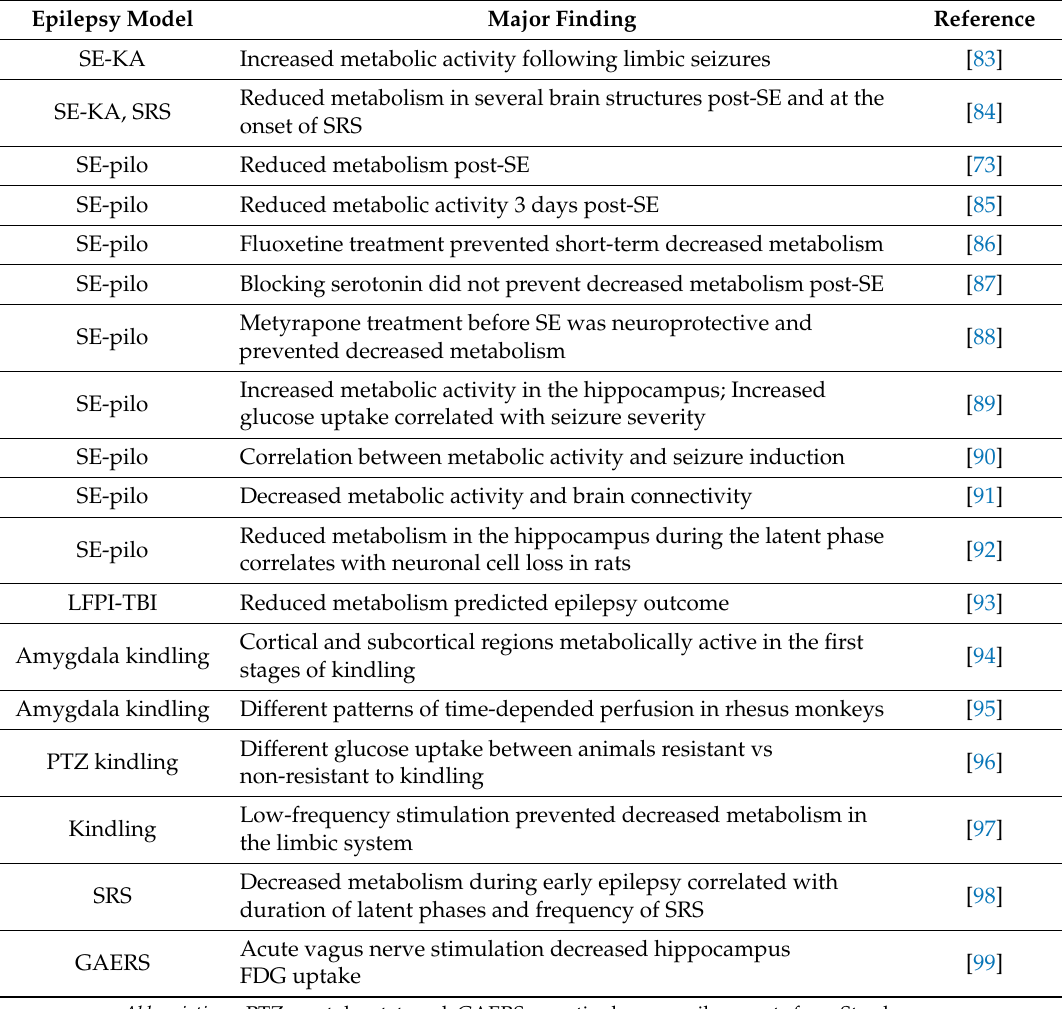
Table 8. List of PET-FDG studies for brain glucose metabolism and potential biomarkers for epilepsy. Epilepsy